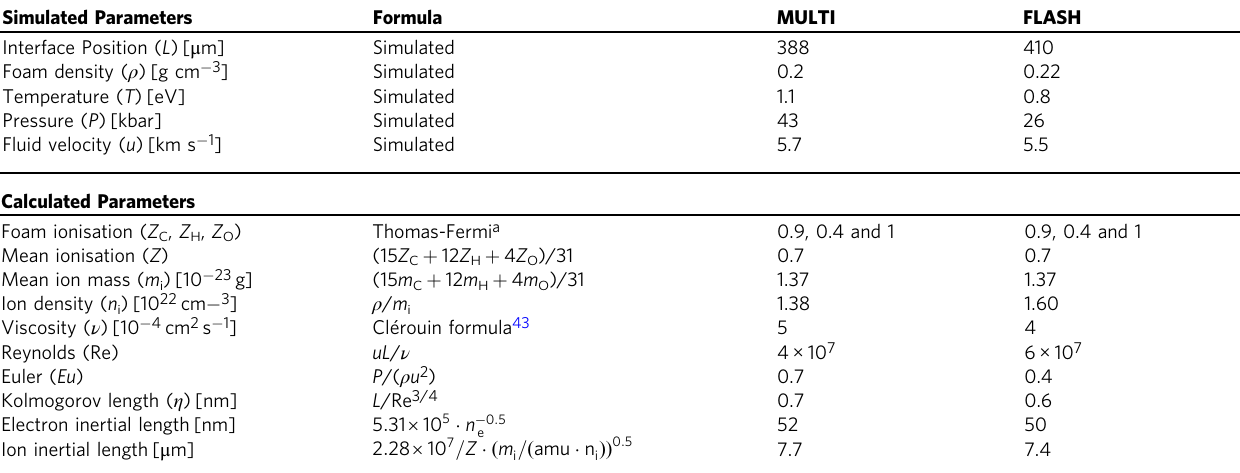
Fig. 3 Experimental radiograph showing the dynamic of the bi-mode targets. The position of the ROI taken to calculate the spectrum of Fig. 4 is shown with a red square. Table 1 Plasma parameters. Summary of different plasma parameters relevant to the fl ow. The “ simulated parameters ” are deduced from simulations. They are taken in the foam near the RTI peak at the proximity of the interface. The “ calculated parameters ” are determined through the formula (in cgs units, amu is the atomic mass unit) using the simulated parameters. Alternative values for the parameters depending on L and u can be found in Table 2, where a more conventional calculation method is